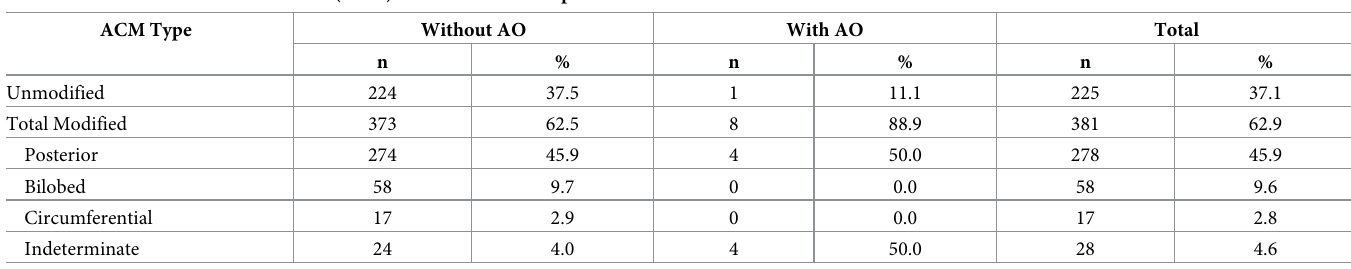
Table 2. Artificial cranial modification (ACM) observed in the